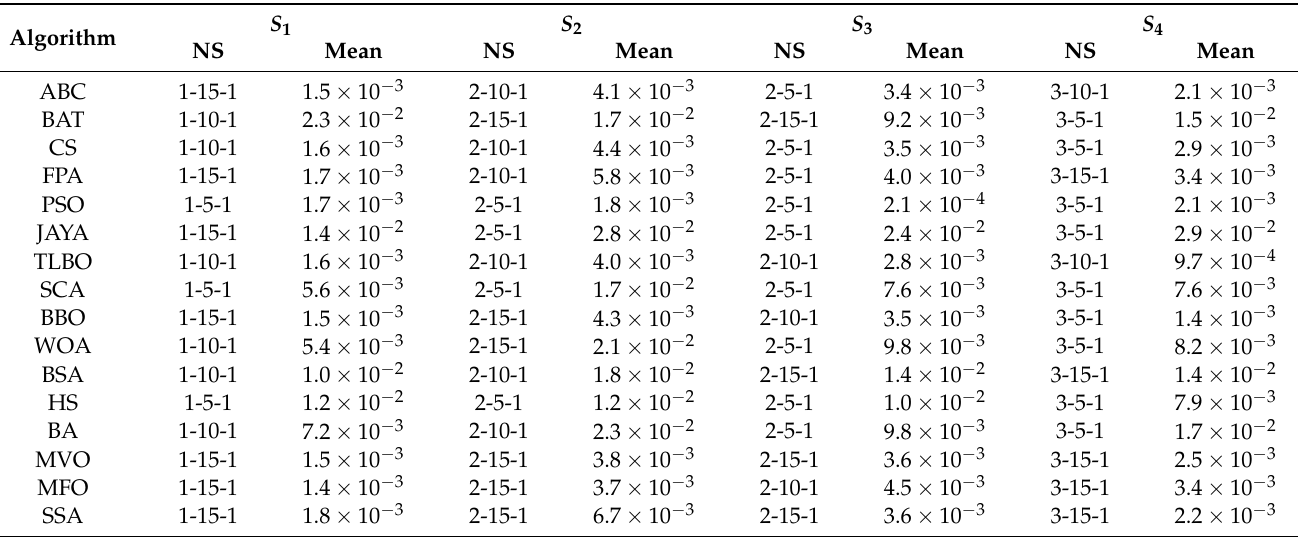
Table 10. The best test results obtained with the relevant metaheuristic algorithms for S 1 , S 2 , S 3 , and S 4 (NS: network structure).